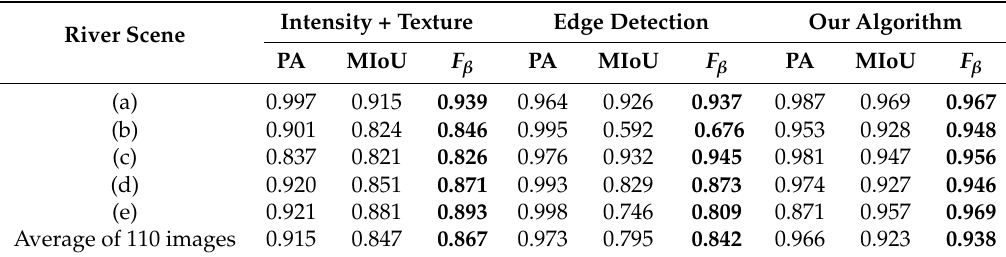
Figure 10. Segmentation results of different methods in simple scenes ( a – e ). From left to right, the first column shows the input images after pre-processing; The second and third column are the segmentation results using “intensity + texture” features and the adaptive threshold edge detection algorithm respectively; The fourth column are the results of our method. Table 1. Performance of different methods in simple